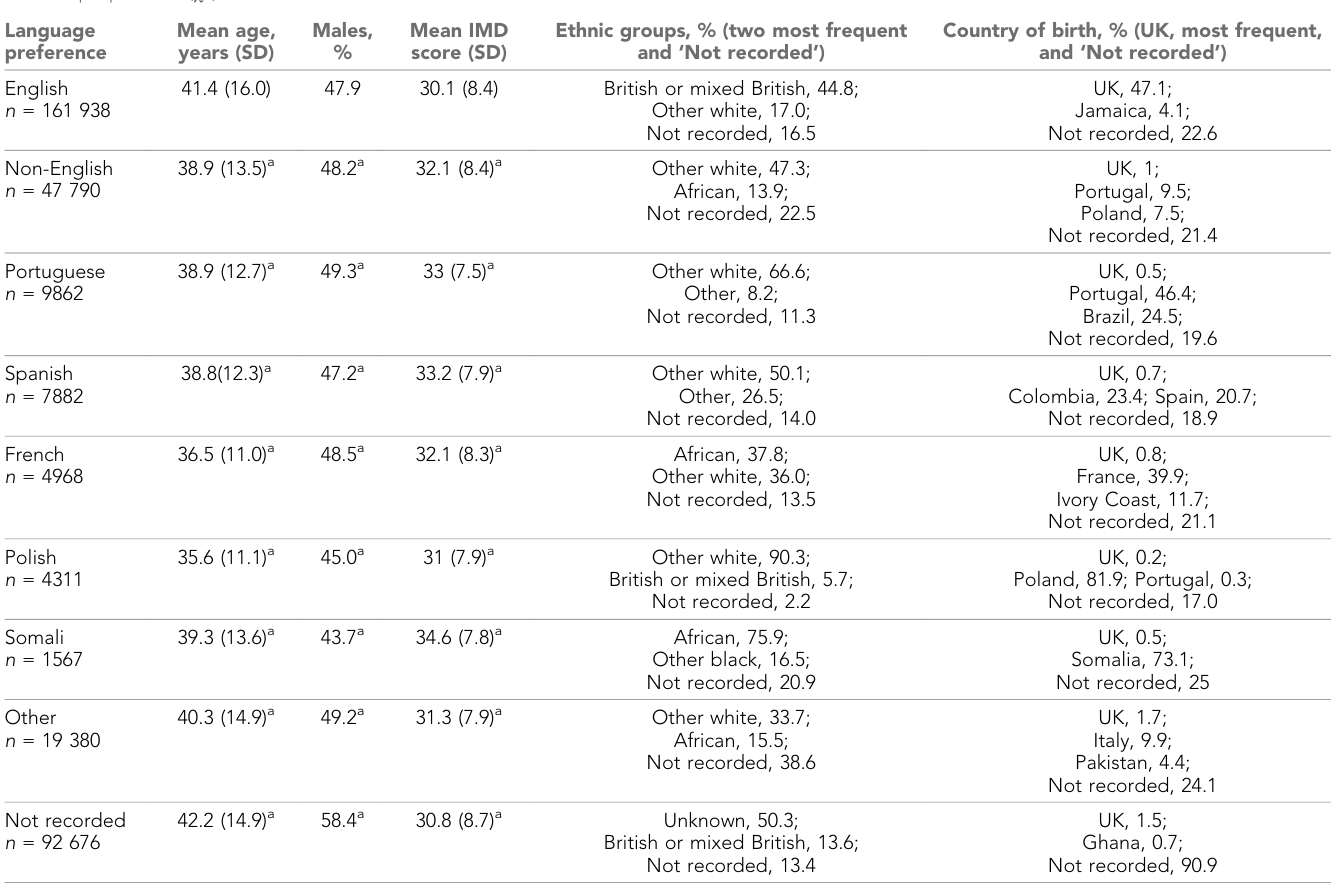
Table 1. Demographic characteristics compared between English language preference and other language preference groups using means ( t -tests) and sex proportions ( c 2